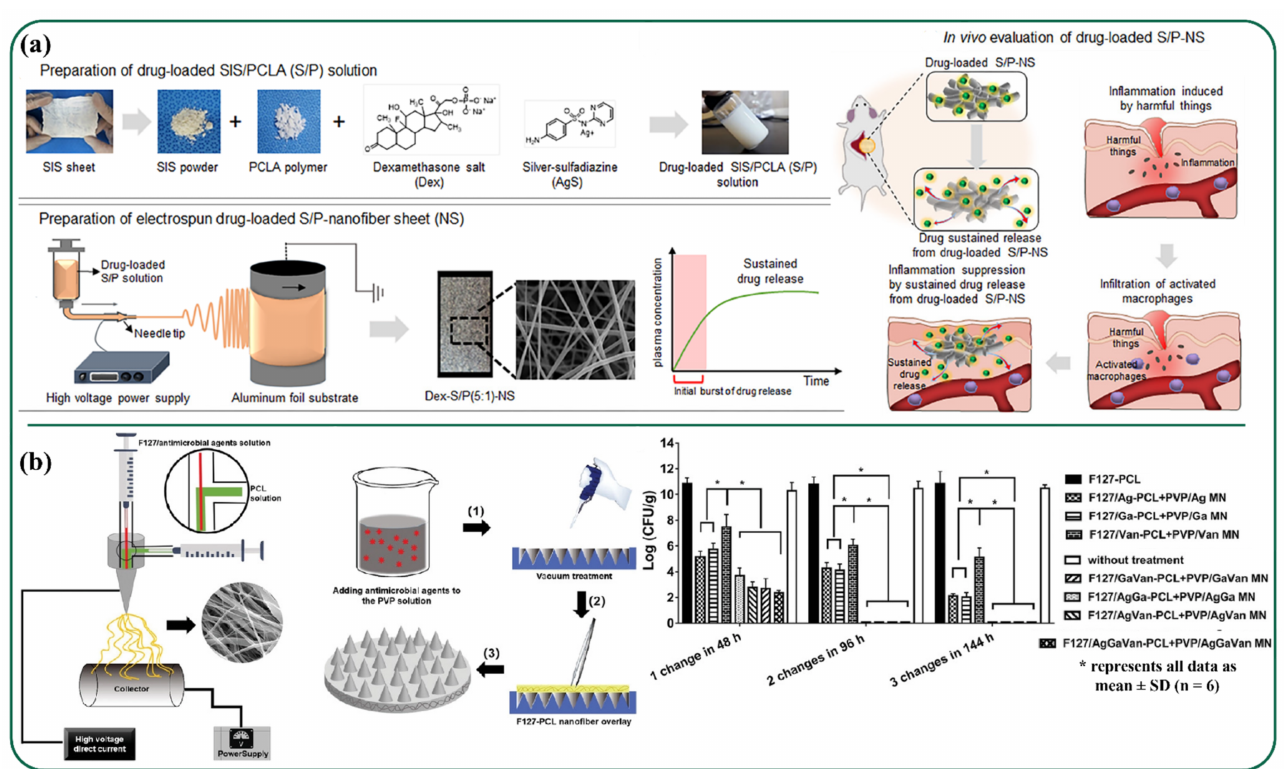
Figure 6. ( a ) Preparation and evaluation of drug-loaded nanofiber [135]. ( b ) Graphical representation of the fabrication of scaffolds; preparation of antimicrobial agents/core–sheath nanofiber mats using coaxial electrospinning; efficacy of single and multiple antimicrobial agents containing biphasic scaffolds against mixed-MRSA/P. aeruginosa biofilms using different administration strategies